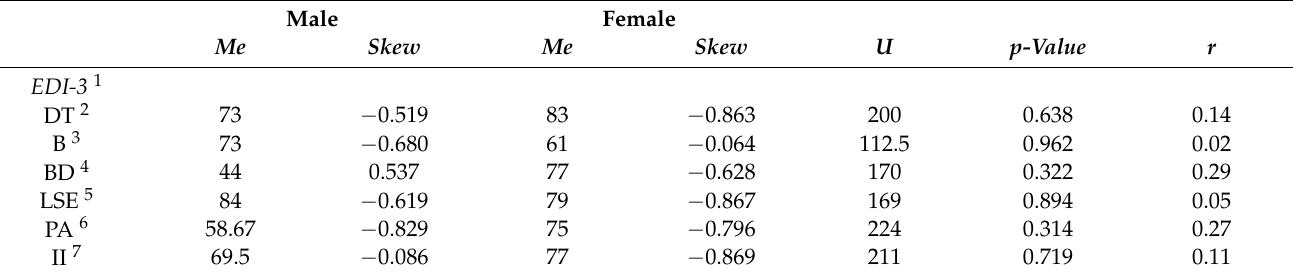
Table 7. Differences in psychological tests in Middle